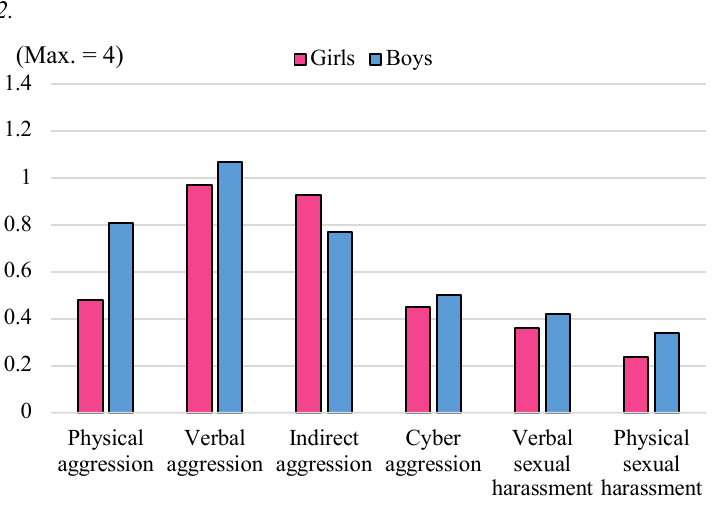
Mean scores for victimization from six types of aggression and sexual harassment, according to sex (N = 1,597). For significant differences, cf. Table 2.